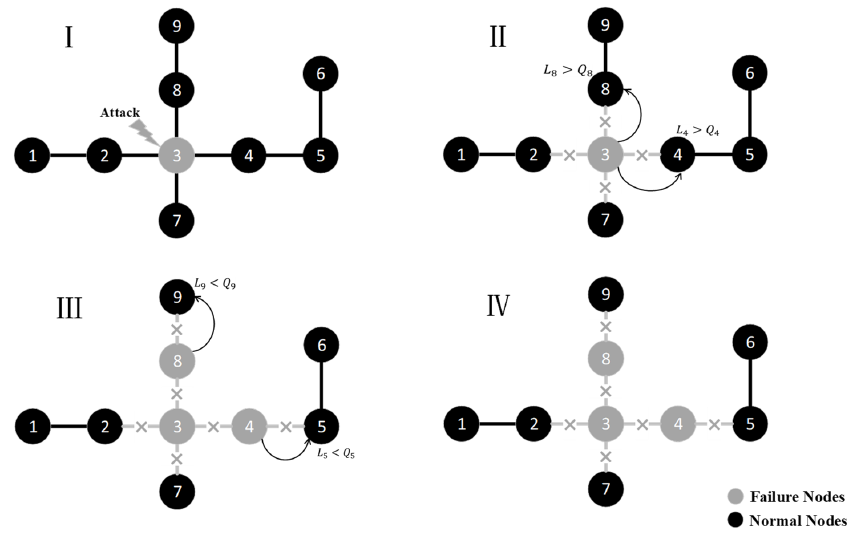
Figure 2. Node cascading failure process.